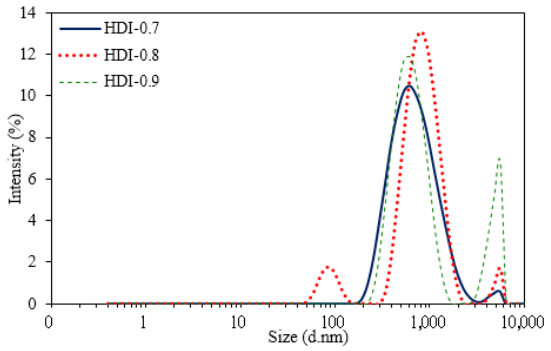
Figure 8. Particle size distributions of WUOs synthesized using HDI and different NCO/OH mole ratios.